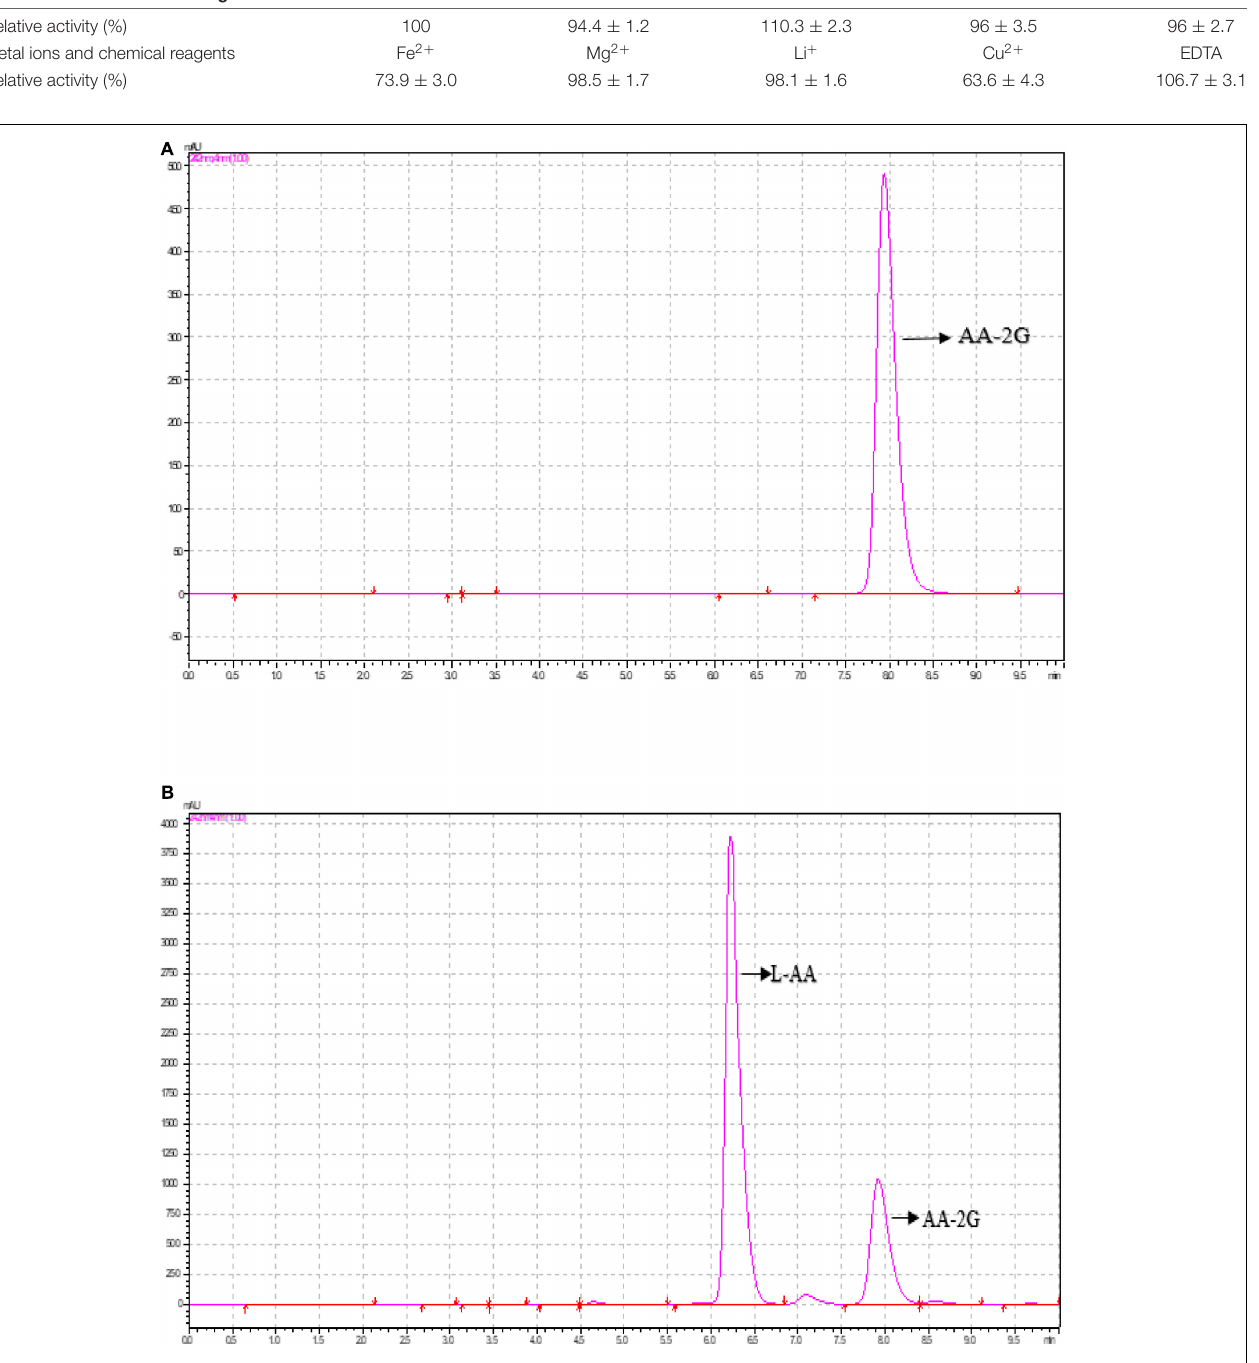
FIGURE 4 | HPLC analysis of 2- O - α - D -glucopyranosyl- L -ascorbic acid (AA-2G) production by the recombinant CGTase. (A) Standard sample of AA-2G, (B) reaction mixture.